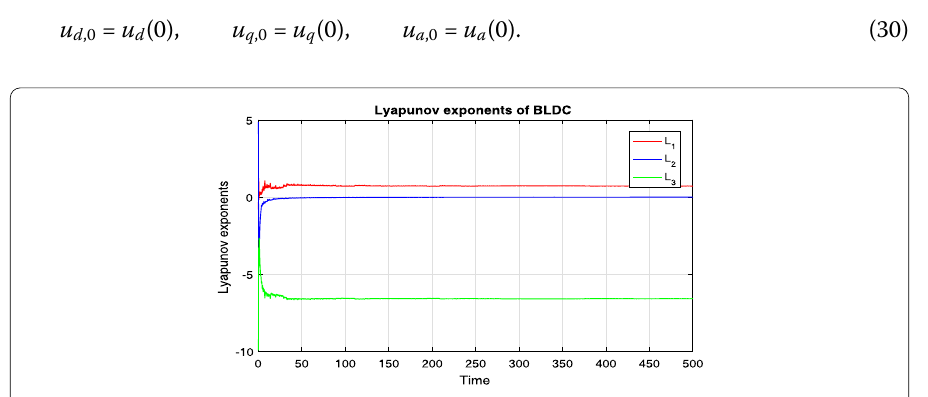
Figure 1 Maximal Lyapunov